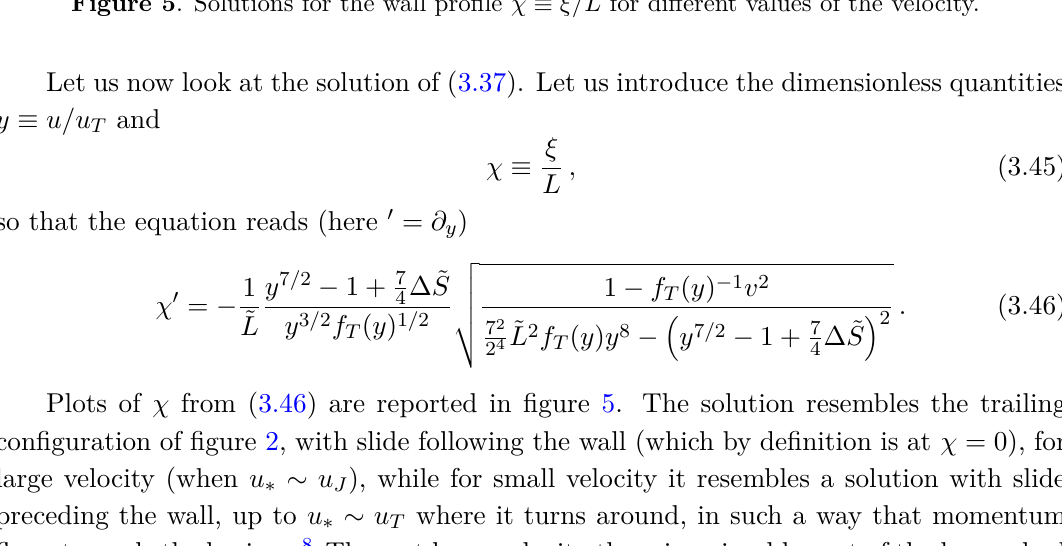
Figure 5 . Solutions for the wall profile χ ≡ ξ/L for different values of the